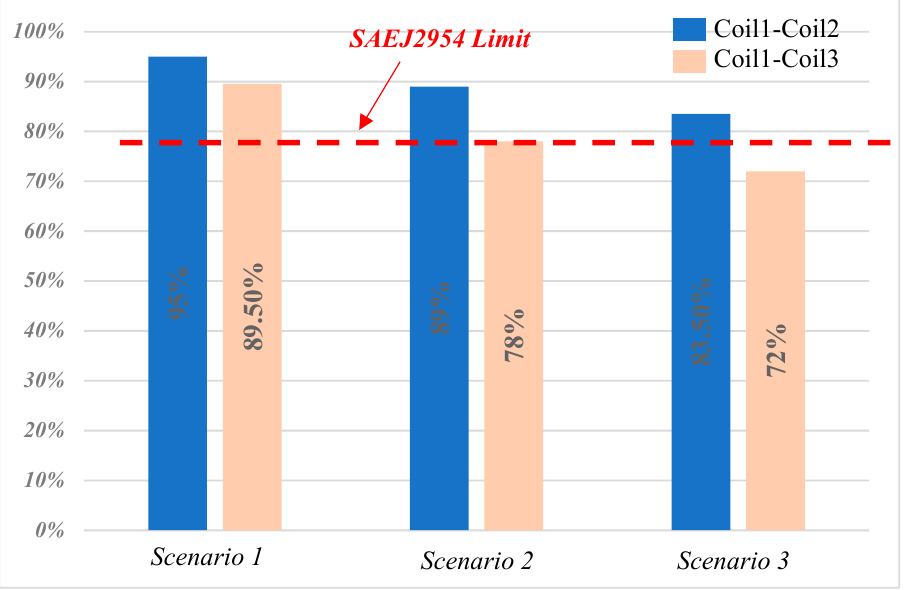
Figure 24. WPT efficiencies for different scenarios of the coil pairs.